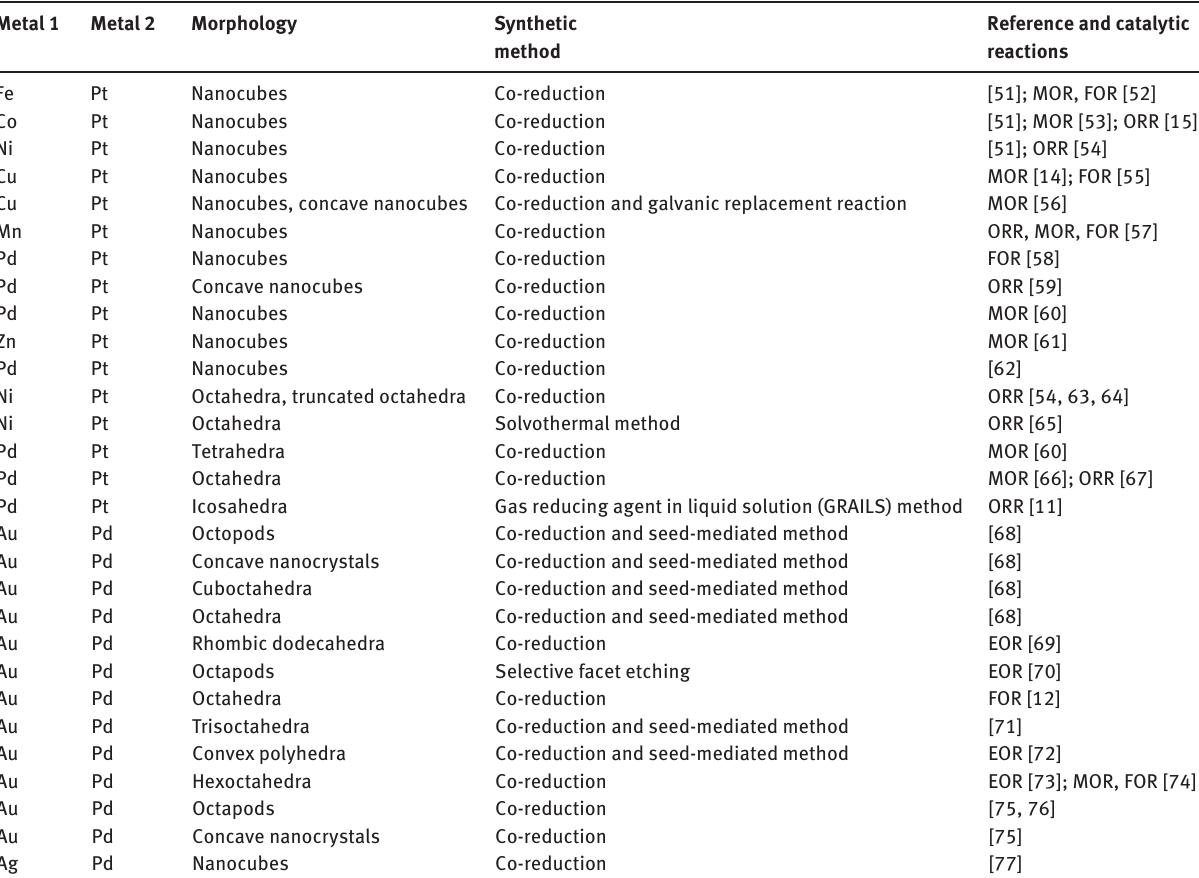
Table 2 List of Pt- and Pd-based bimetallic alloy nanostructures with polyhedral shapes, their synthetic methods, and catalytic reactions. Metal